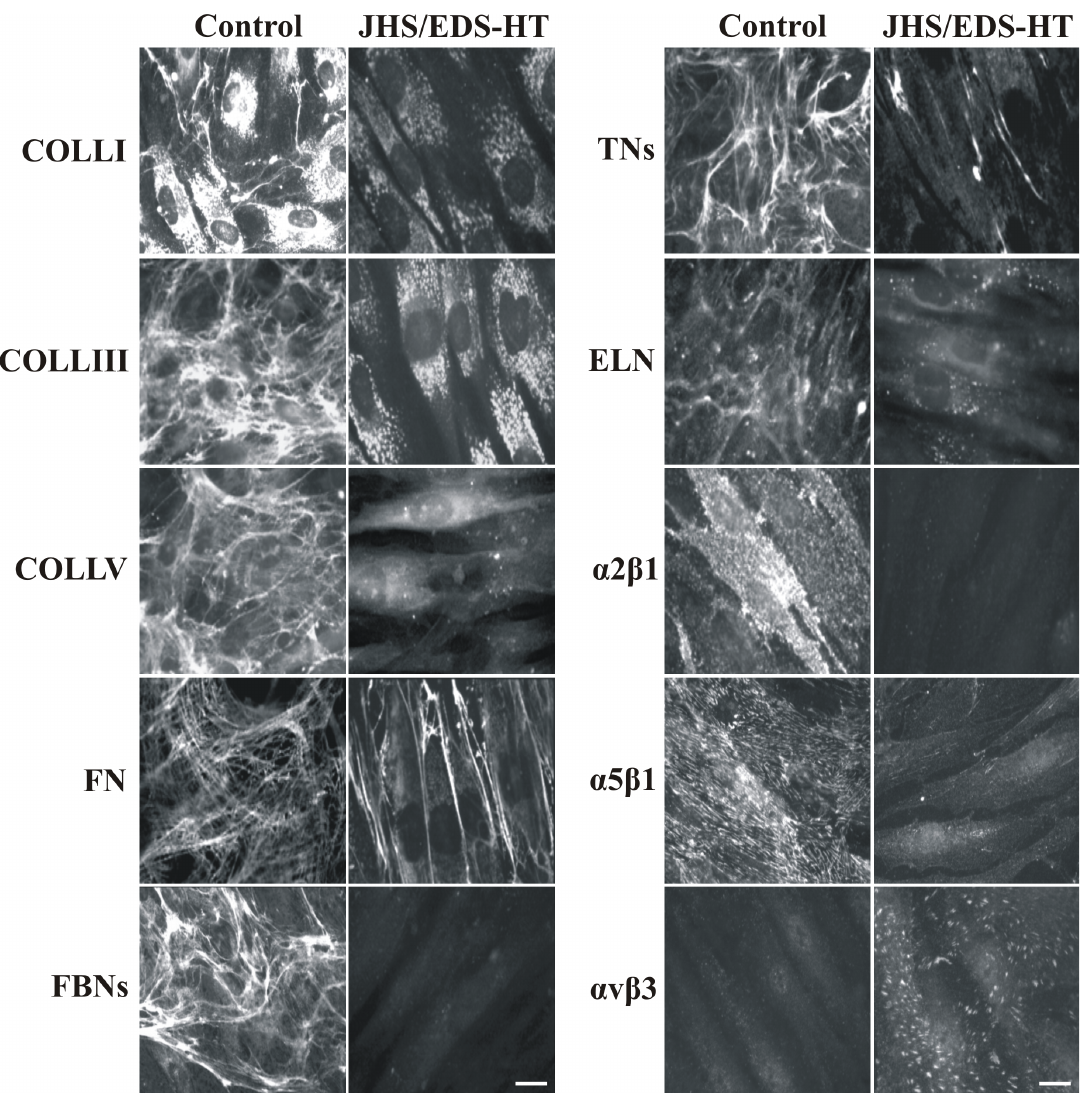
Fig 1. Organization of collagens, other glycoproteins, and their integrin receptors in control and JHS/EDS-HT skin fibroblasts. Left panel: Control and patients ’ cells grown for 48 h were analyzed with specific Abs directed against COLLI, COLLIII, and COLLV. FN was investigated by labeling the cells with an Ab recognizing all of FN isoforms. Scale bar: 10 μ m. Experiments were repeated three times. The images are representative of three control and five JHS/EDS-HT cell strains. Right panel: TNs were investigated by labeling the cells with a specific Ab recognizing all TN isoforms. The α 2 β 1, α 5 β 1, and α v β 3 integrin receptors were analyzed with specific mAbs recognizing their ligand-binding sites. All of the proteins were investigated 48 h after seeding. IF of ELN was performed on the control and patients ’ fibroblasts 7 days after seeding using a specific Ab. Scale bar: 10 μ m. Experiments were repeated three times. The images are representative of three control and five JHS/EDS-HT cell